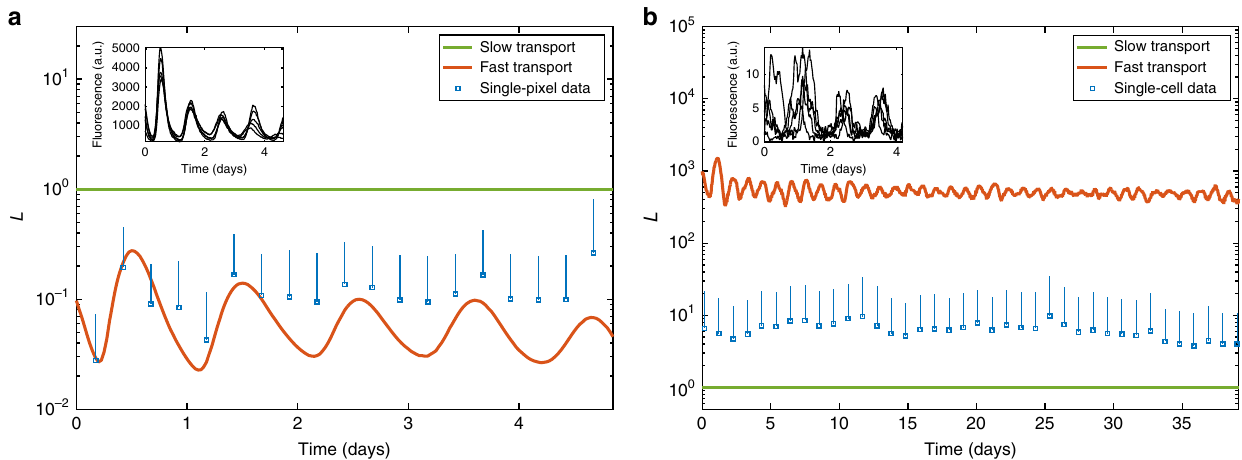
Fig. 6 Comparison of fast (red) and slow (green) transport limits with single-pixel data (blue squares: mean; blue bars: 1 standard deviation above mean) for a a single leaf of Arabidopsis thaliana , b a population of 30 mouse fi broblast cells. Insets: typical single-cell trajectories from the raw data. Data is taken from a ref. 19 , available at ref. 39 , b ref.